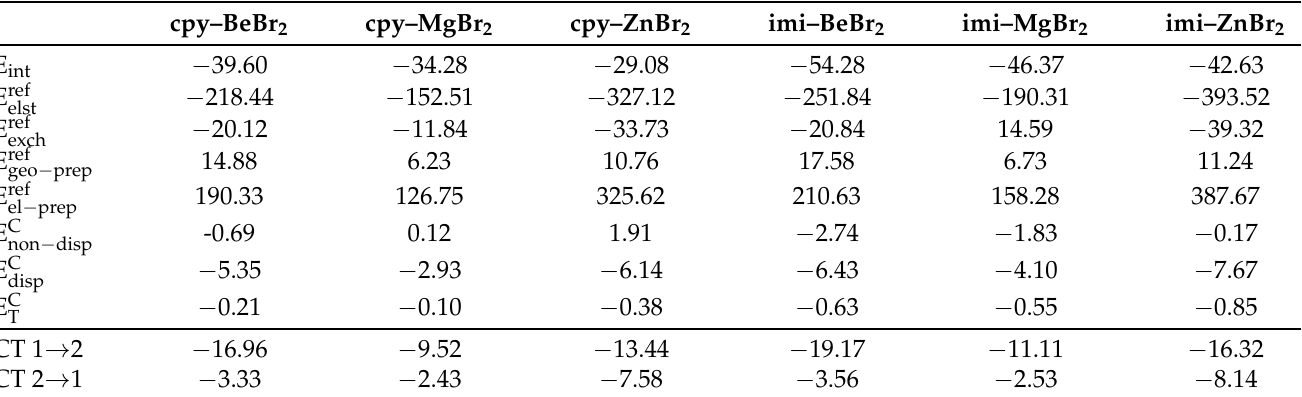
Table 5. DPLNO-CCSD(T)/ccpv-tz Local Energy Decomposition analysis of the {carbene} · · · {MX 2 } bonding (carbene names shortened for clarity: cpy = cyclopropenylidene and imi = imidazol-2- ylidene). Energies in kcal/mol.